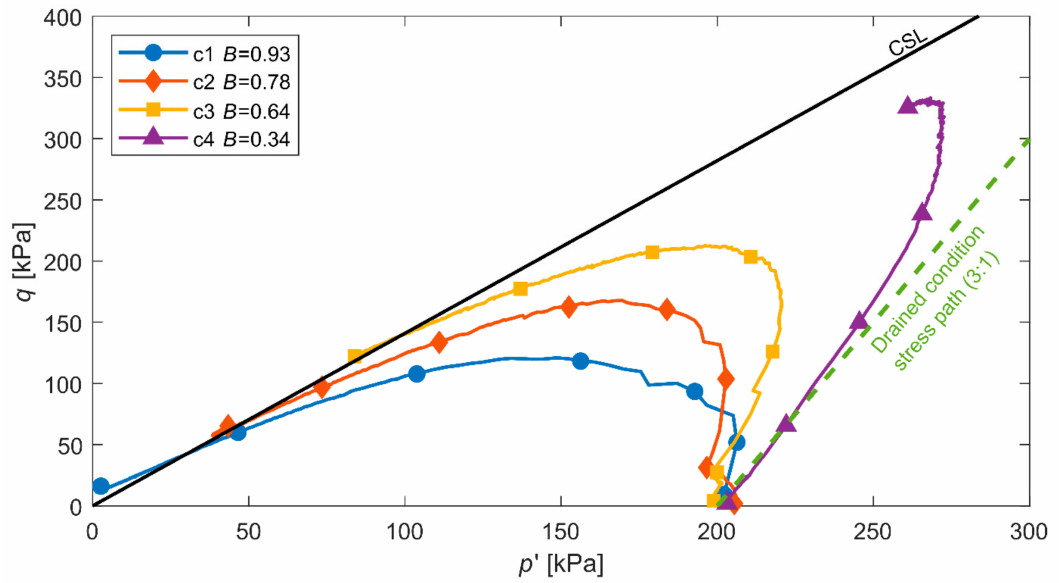
Figure 14. Stress paths corresponding to the behaviour of Skarpa sand at different levels of